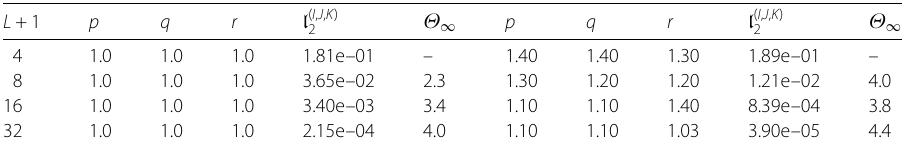
Table 2a Errors and order for UM-FOCS and EEG-TOCS in Example 5.2